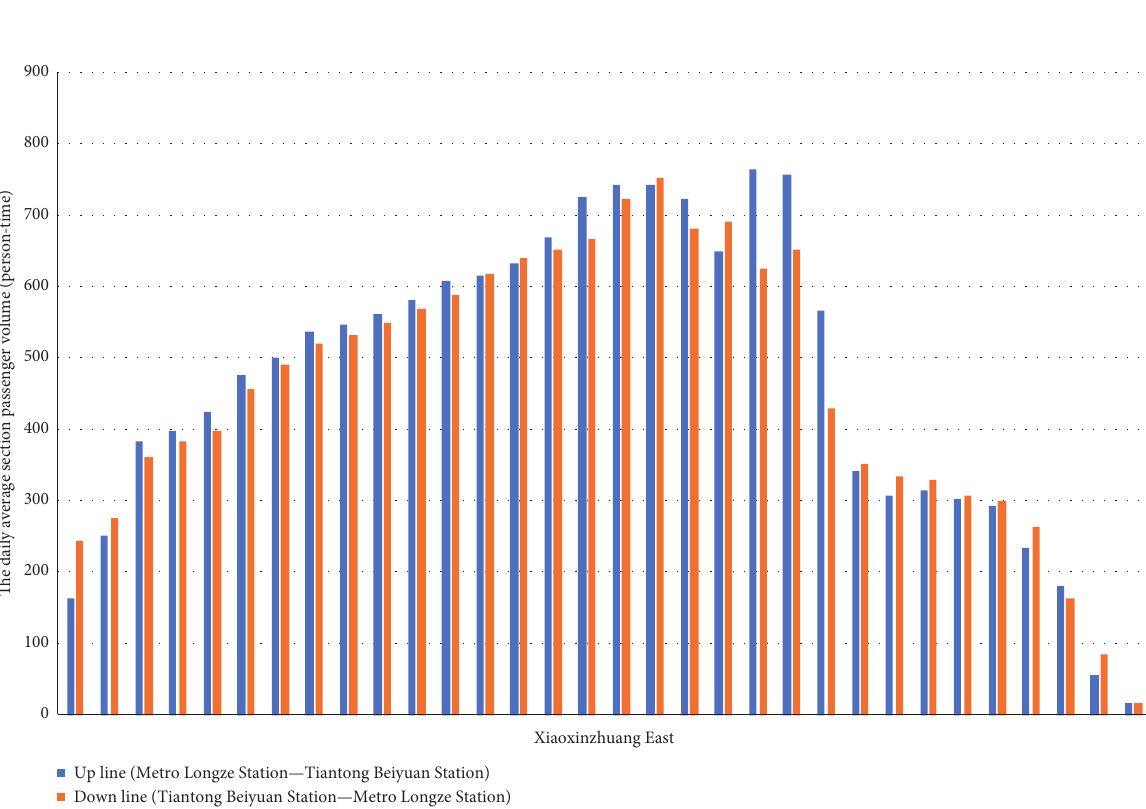
Figure 2: The boarding and landing